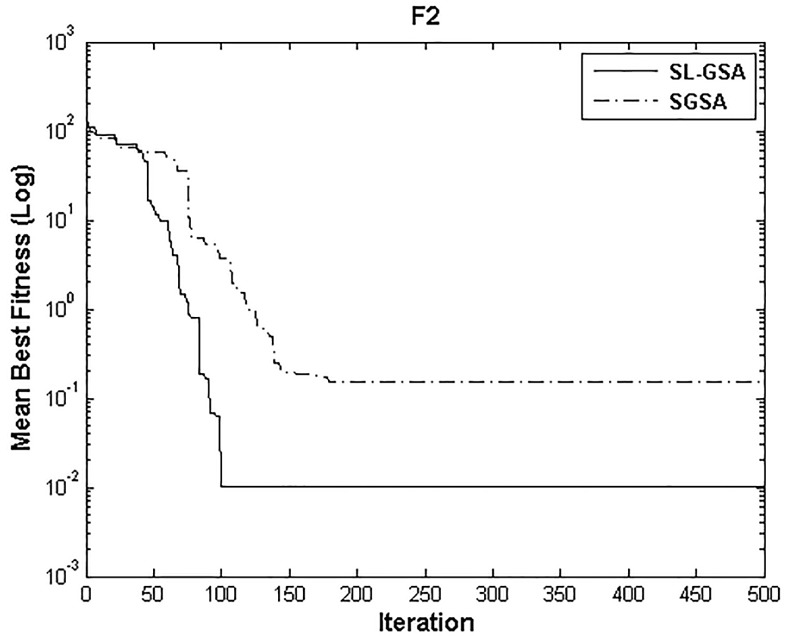
Performance comparison of SGSA and SL-GSA for minimization of F2.